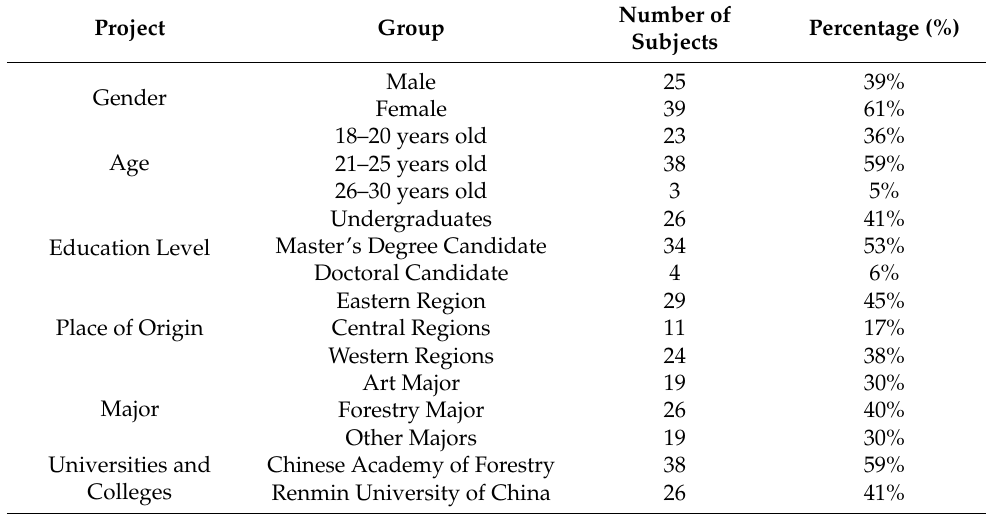
Table 1. The demographic characteristics of the study participants.